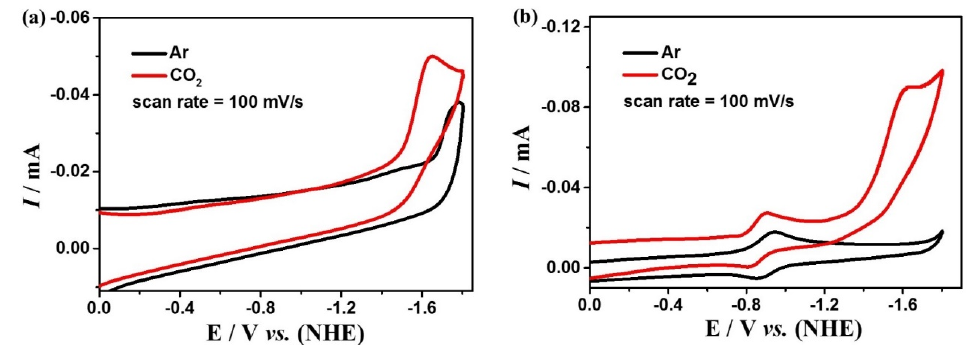
Figure 6. Cyclic voltammetry of 0.5 mM complexes 1 ( a ) and 2 ( b ) in the DMF solution under CO 2 (red) and Ar (black) at glassy carbon.